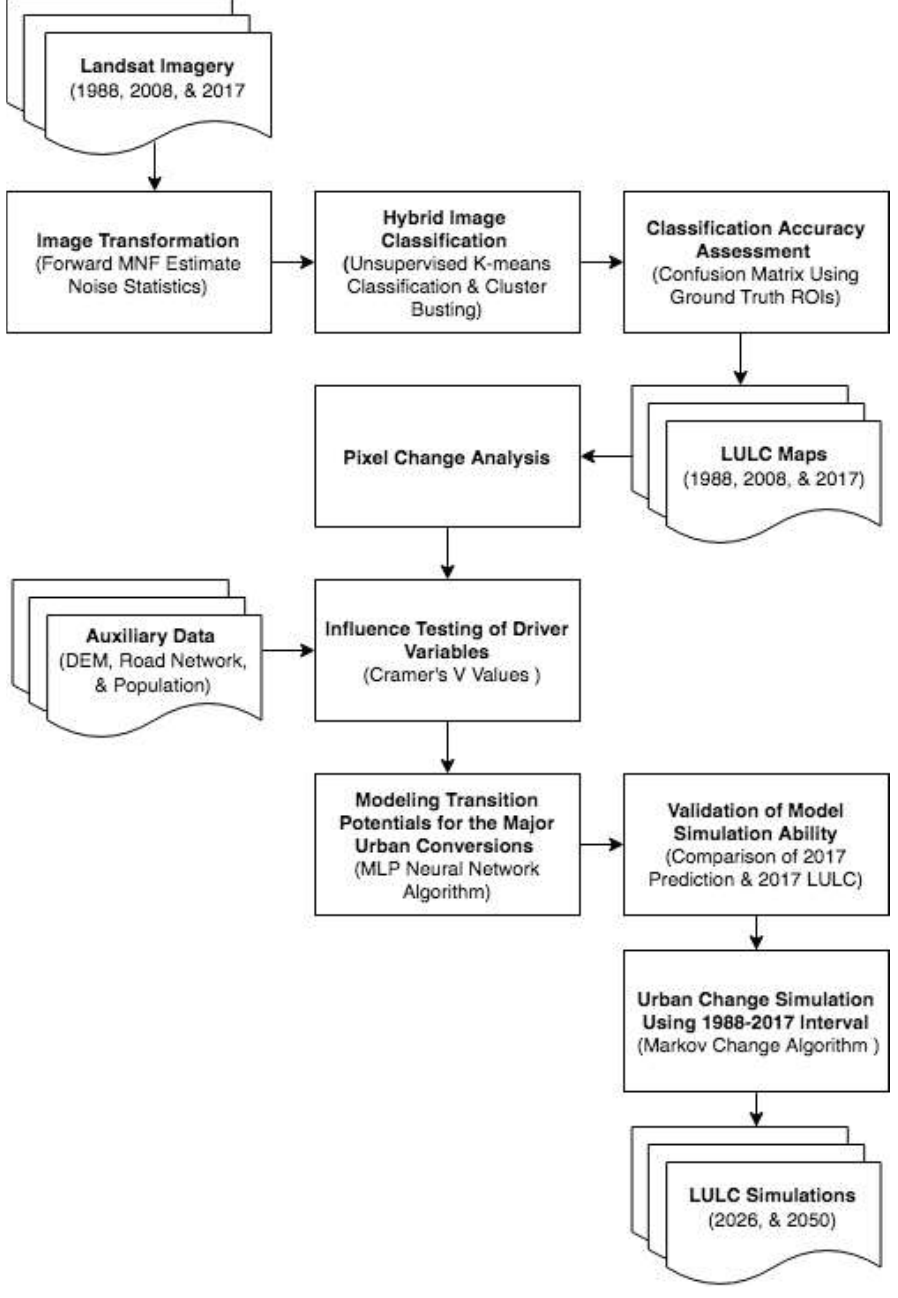
Figure 2. Simplified project workflow.